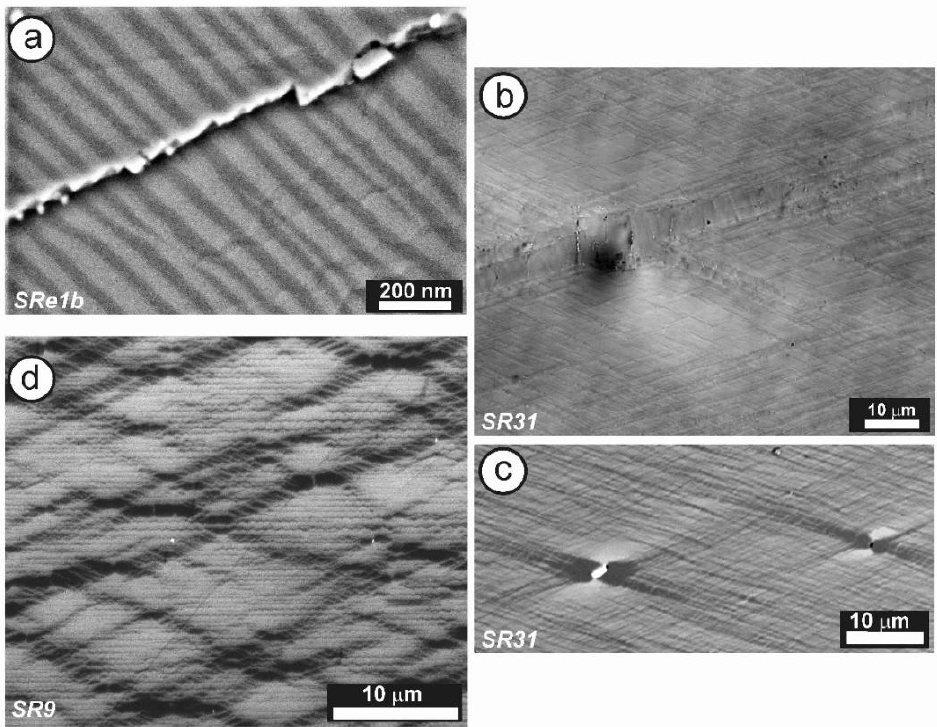
Figure 18. ( a ) BSE image of the cryptoperthitic texture in specimen SRe1b in a (001) section, with Na lamellae in light gray and K-rich lamellae in dark gray of average thickness of about 30 nm, resolved by using a high-resolution field-emission SEM equipment (Thermo Scientific Apreo 2, HV at 1.5 kV, 13 pA, WD = 4.0 mm, HFW = 1.27 µ m, and at × 100,000 magnification). ( b ) Optical micrograph close to the parallel position in a (001) section in specimen SR31, using transmitted light and parallel polarizers using a × 100 oil objective, in a Nikon Eclipse LV100 POL microscope. ( c ) BSE image of the crypto- and microperthitic texture of specimen SR31, with a contrast between the two compositional lamellae similar to the previous one, using a FEI Inspect SEM microscope, HV at 30.0 kV, WD = 7.9 mm, spot at 4.6, at × 5000 magnification. ( d ) BSE image of the crypto- and microperthitic texture of specimen SR9, using the same experimental conditions as in ( c ), at × 8000 magnifi- cation.